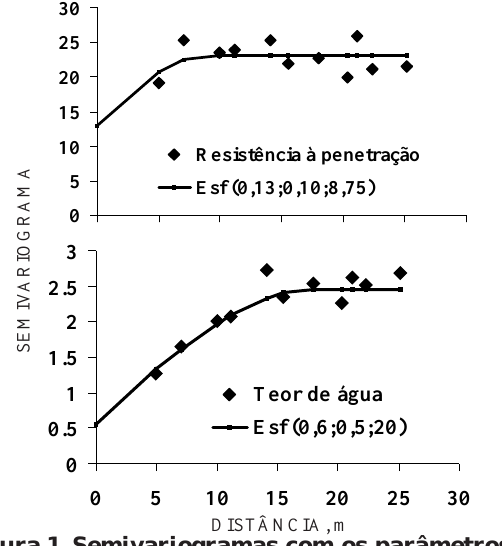
Figura 1. Semivariogramas com os parâmetros de Figura 2. Coeficiente de correlação entre a densi- ajuste esférico (Esf (C ; C ; a)) para resistência dade do solo (g cm -3 ) a 15 e 25 cm de profundi- 0 1 à penetração (MPa) e teor de água (g g -1 ) de dade e a retenção de água (m 3 m -3 ) nas seis ten- 0–25 cm de sões (MPa).